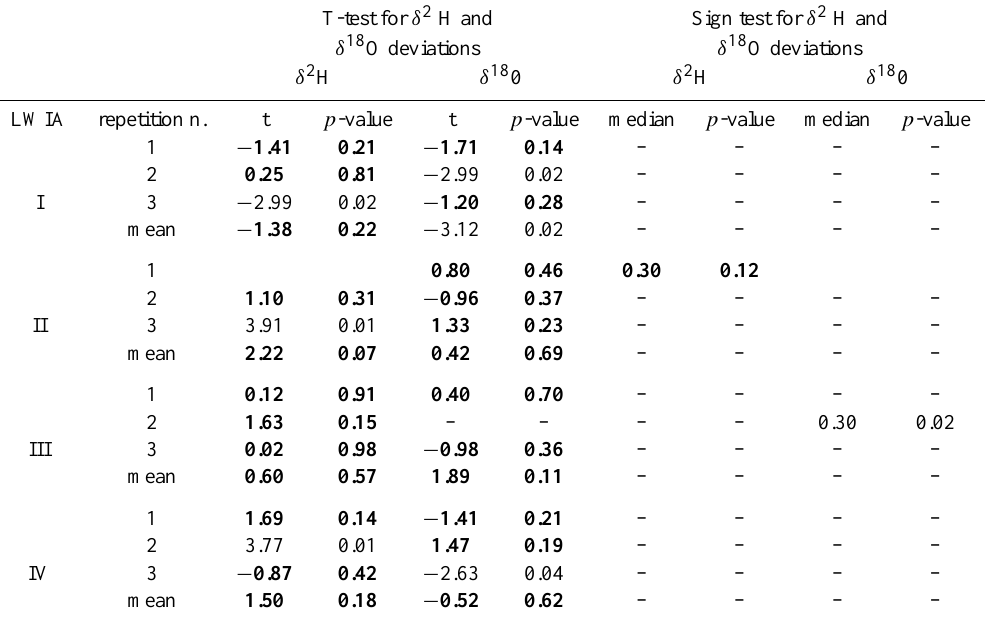
Table 7. Results of one-sample t-test and one-sample sign test for δ 2 H and δ 18 O deviations of repeated samples. The analyses that produced negligible differences between laser spectroscope and mass spectrometer (i.e., not significant difference with α :0.05) are marked in bold. T-test for δ 2 H